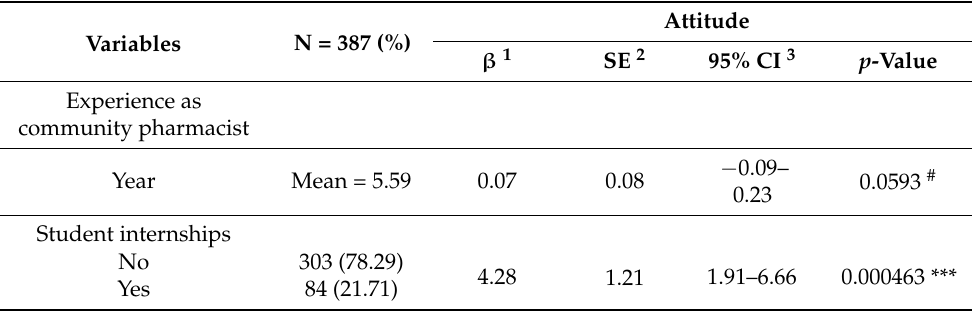
Table 7. Bivariate analysis of Attitude with work employment